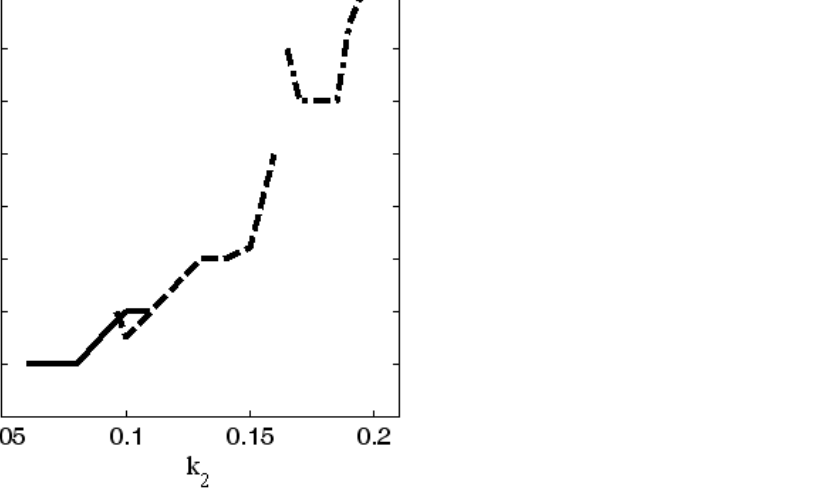
k at 01 . 0 = = I I — dash dot Figure 6. Dependence of period of oscillations on the values of Figure 6. Dependence of period of oscillations on the values of k 2 at I 1 = I 2 = 0.01 —dash dot line; 2 1 2 == II — solid line. All other parameter values are as = = I I — dashed line; 1.0 I 1 = I 2 = 0.05 —dashed line; I 1 = I 2 = 0.1 —solid line. All other parameter values are as those in line; 05 . 0 21 2 1 those in (5).